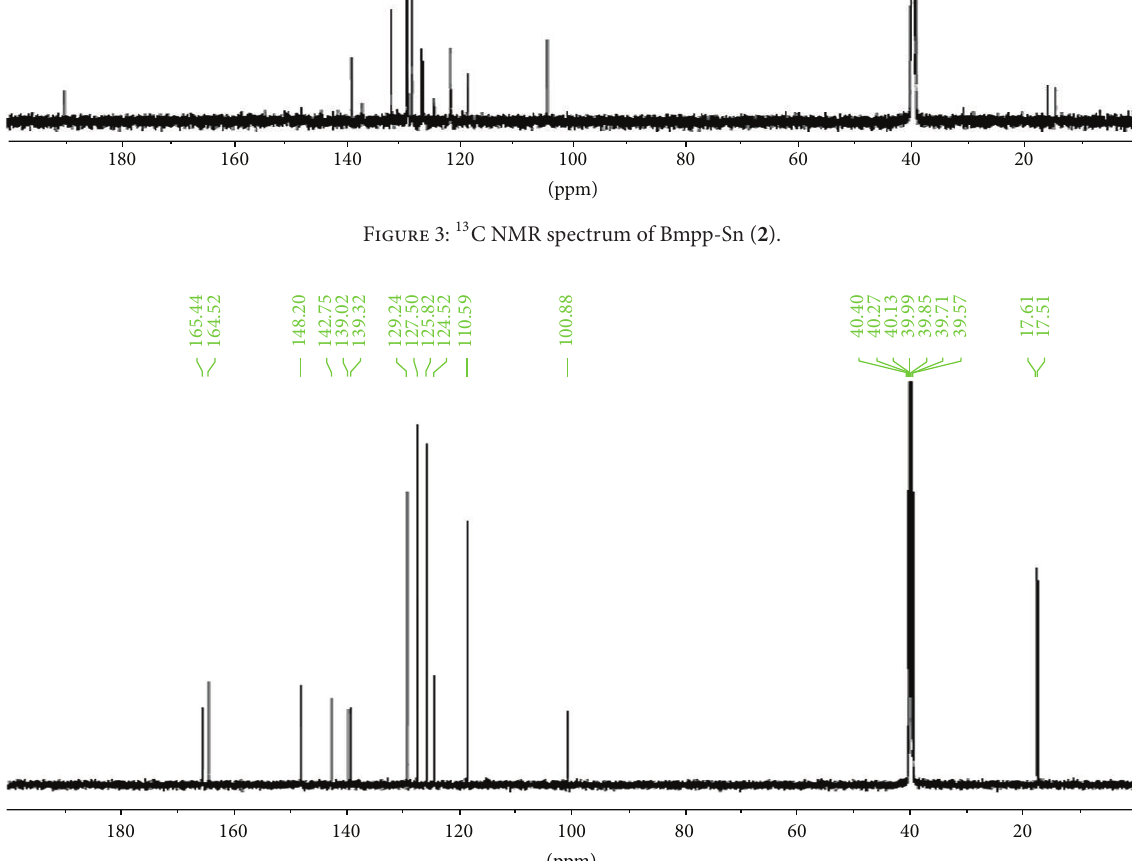
Figure 4: 13 C NMR spectrum of Ampp-Sn ( 1